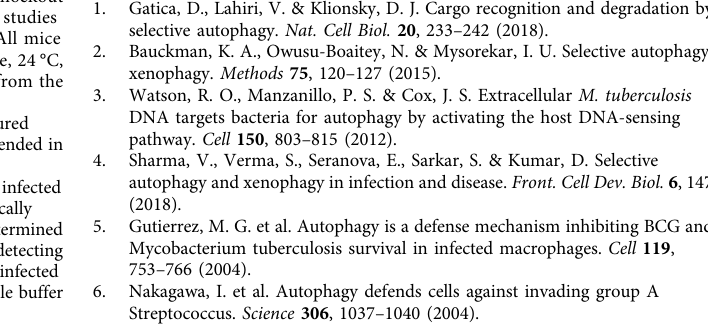
Protein level of RhoB, Beclin 1 and LC3 in RhoB + / − and RhoB − / − mice infected by CFT073 through immunohisto fl uorescence analysis. Quanti fi cation